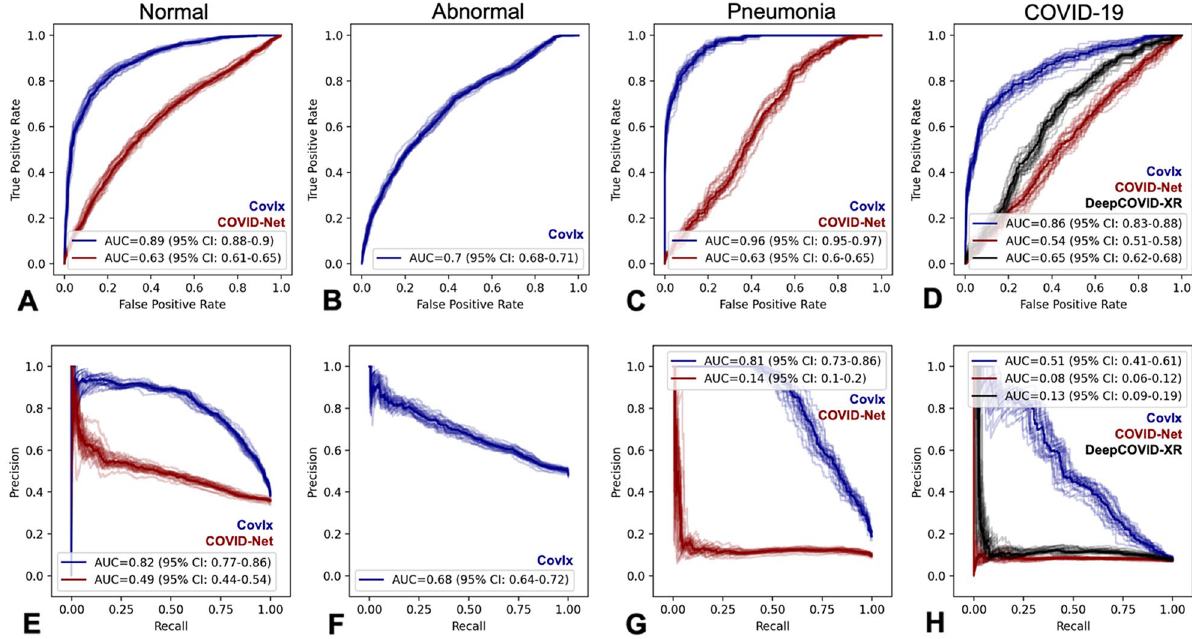
Figure 4. Discriminative performance of Chest-Xray classification algorithms on prospectively collected testing set of 3289 images. Discriminative capacity of CovIx (blue), COVID-Net (red), and DeepCOVID-XR (black) is represented as Receiver Operating Characteristics (ROC) ( A-D ) or Precision-Recall (PR) ( E-H ) curves. 95% Confidence Intervals (CI), generated using 2000 bootstrap samples, are visualised as pale curves.